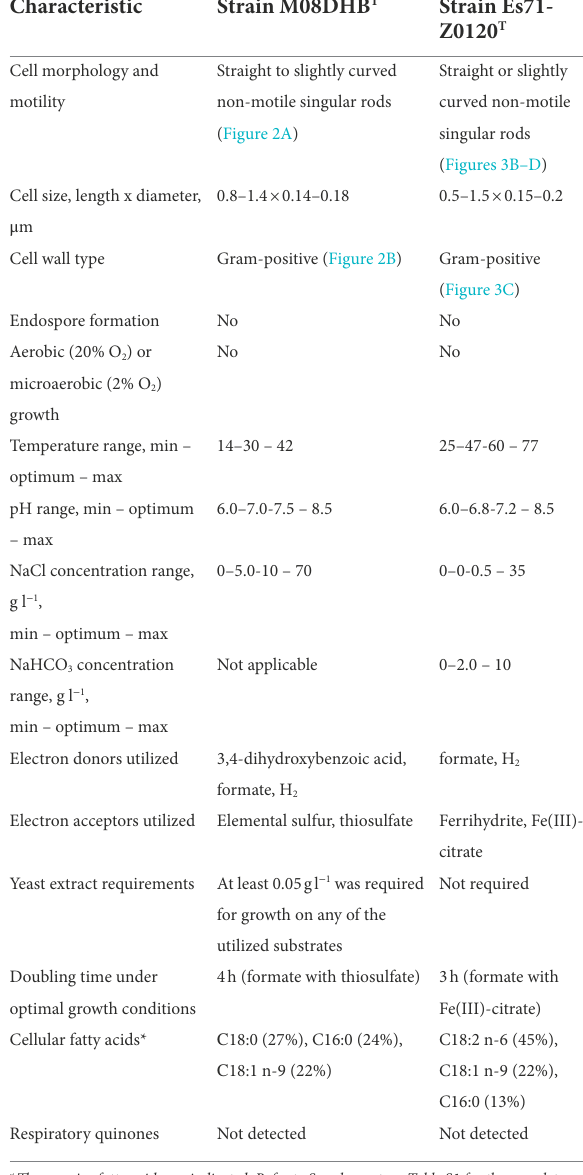
TABLE 1 Morphological, physiological and chemotaxonomic characteristics of strains M08DHB T and Es71-Z0120 T .